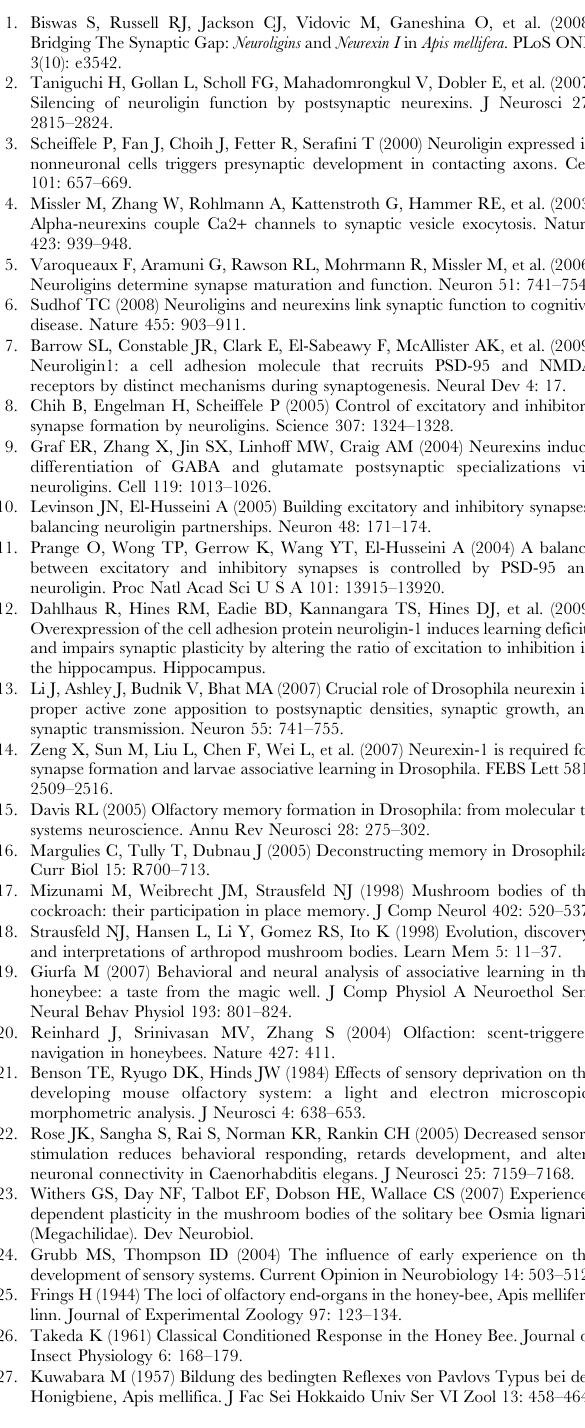
Table S3 Quantitative real time PCR data of neuroligin and neurexin I expression in bees with left or right antennal